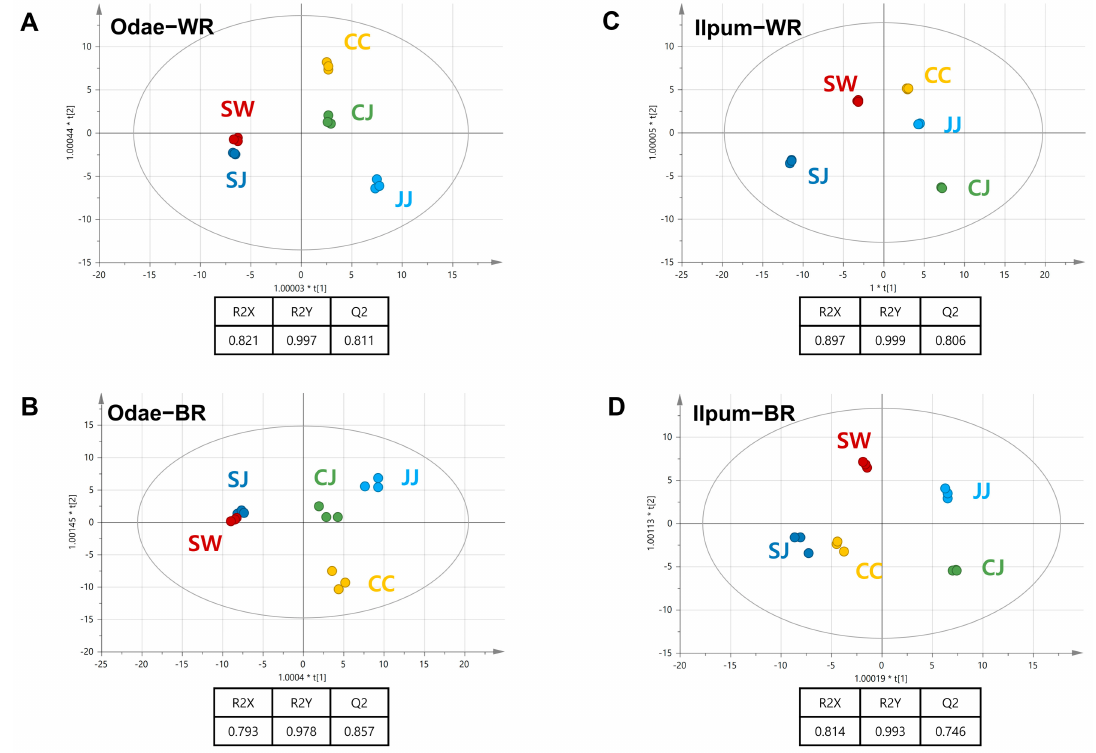
Figure 4. Cultivation-regional specificity of the rice profiles based on orthogonal projection to latent structures-discriminant analysis (OPLS-DA). The score plot of the rice profiles cultivated in 5 different regions for Odae-white rice, ( A ) for Odae- brown rice, ( B ) for Ilpum-white rice, and ( C ) for Ilpum-brown rice. ( D ) CJ: Cheongju (Chungcheongbuk-do), SJ: Sangju (Gyeongsangbuk-do), SW: Suwon (Gyeonggi-do), CC: Cuncheon (Gangwon-do), JJ: Jeonju